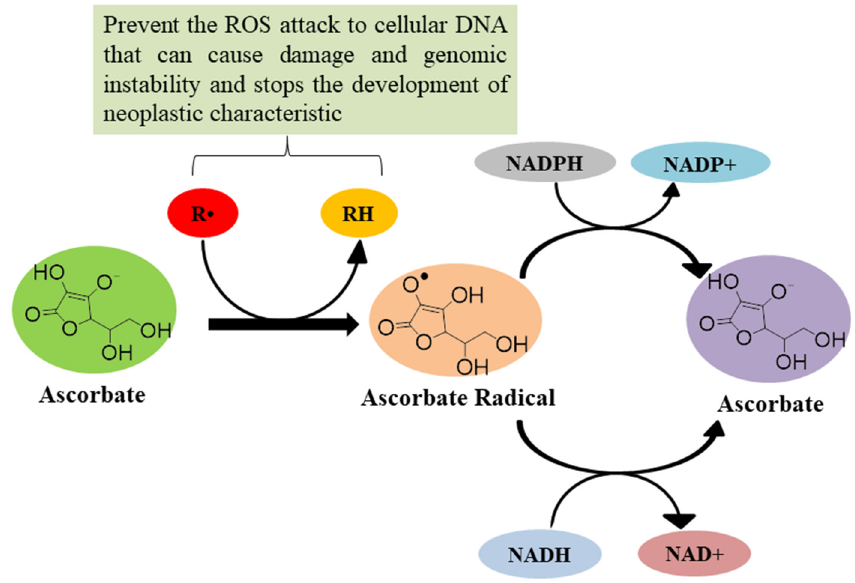
Figure 9. Antioxidant mechanism of ascorbic acid [40,41,71].